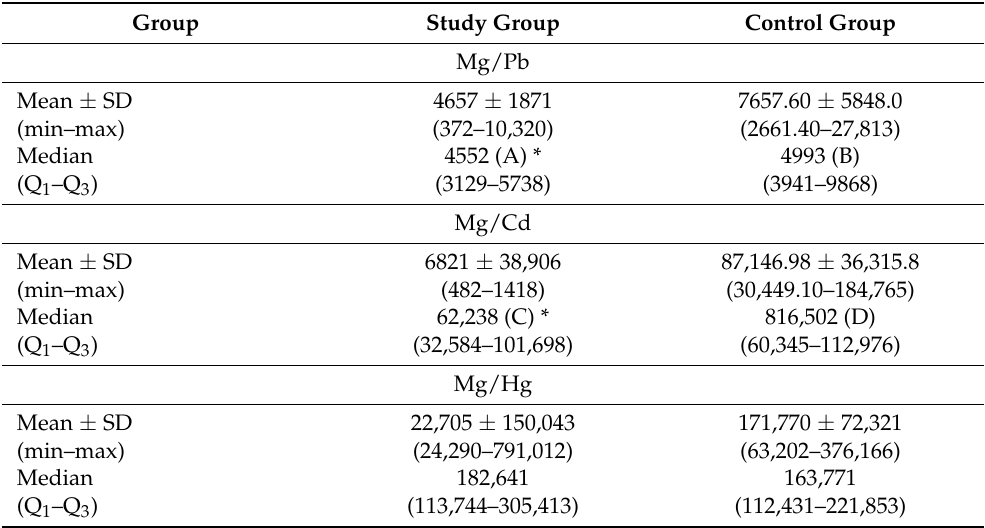
Table 5. Molar ratios of Mg to Pb, Cd and Hg concentrations in patients with osteoarthritis of the spine and healthy